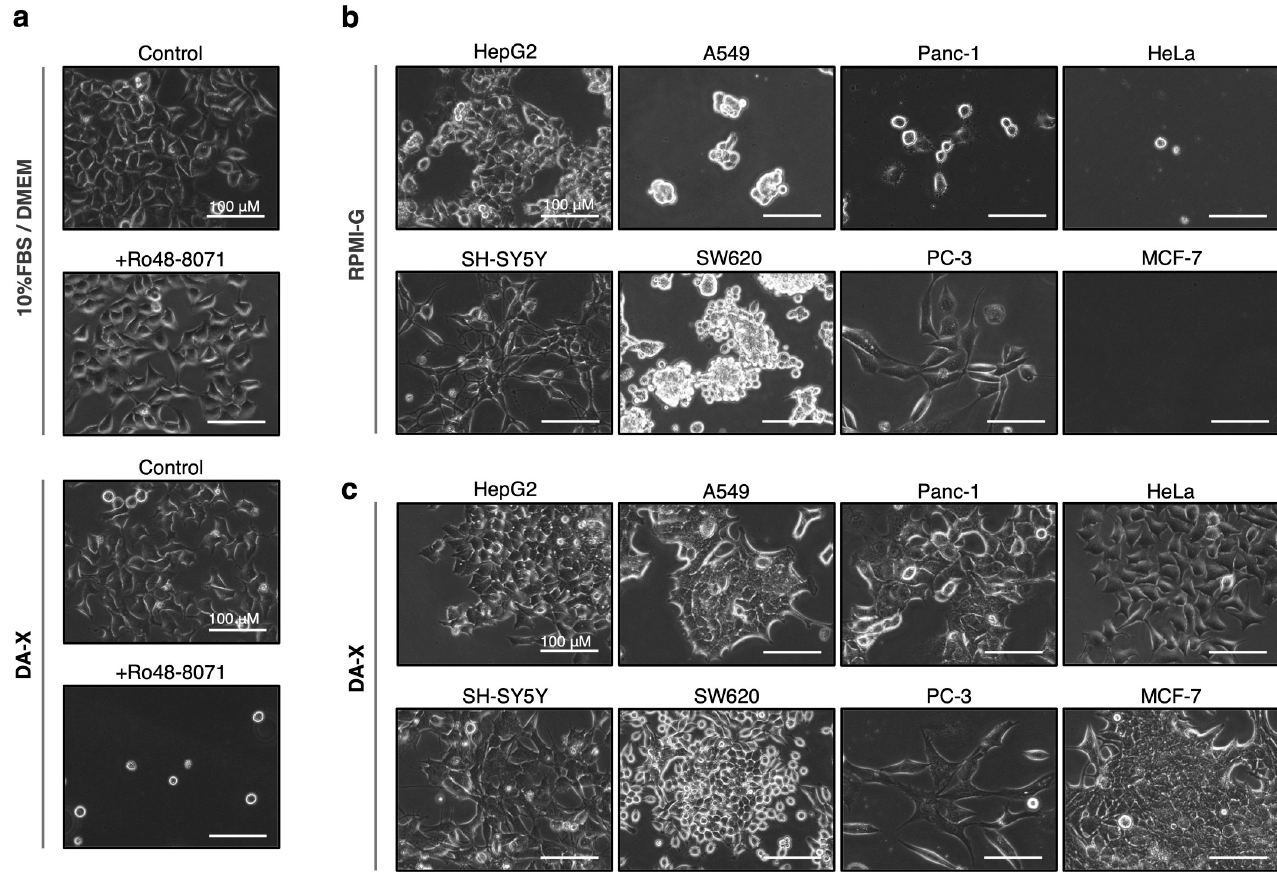
Fig 2. Availability of DA-X condition on analysis for cholesterol function, and in several cancer lines. a, Effect of cholesterol biosynthesis inhibitor, Ro48- 8071, on HeLa cells in serum-containing and -free culture condition for 48 hrs. In cells grown in 10% FBS/ DMEM, Ro48-8071 was shown to have no effect on cell survival and even their proliferation, while almost cells cultured in DA-X condition were shown to be dead. Scale bar, 100 μ m. b and c, Comparison of the effects of RPMI-G medium and DA-X condition on cell adhesion, pseudopodia and proliferation in representative human cancer cell lines of each organ and tissue. Images of cells cultured in RPMI-G (b) and DA-X condition (c) at day 5 are shown. The number of cells at the start of culture was optimized for each cell type to reach about 80% confluency at day 5 in 10% FBS/ DMEM medium (the using cancer cell lines and their number of cells at the start of cultures in one well of a 4-well plate are shown below). HepG2 (hepatoma, 4x10 4 ), A549 (lung cancer, 2x10 4 ), Panc-1 (pancreatic cancer, 4x10 4 ), HeLa (cervical cancer, 2x10 4 ), SH-SY5Y (neuroblastoma, 4x10 4 ), SW620 (colon cancer, 4x10 4 ), PC-3 (prostatic cancer, 3x10 4 ), MCF-7 (breast cancer, 3x10 4 ). Scale bar, 100 μ m.